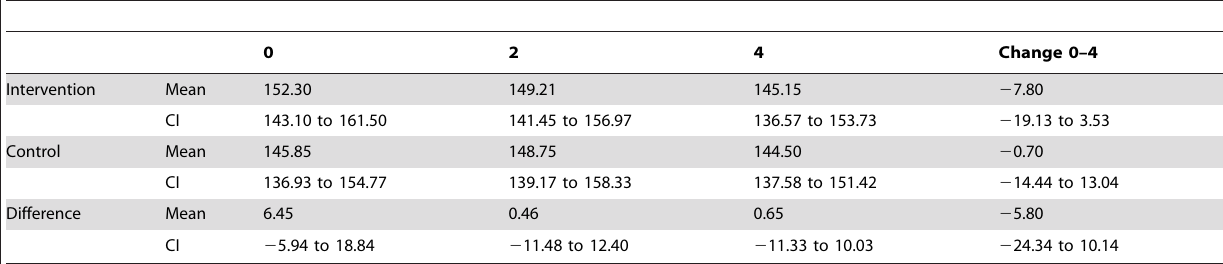
Table 5. Development of Systolic Blood Pressure during the study.